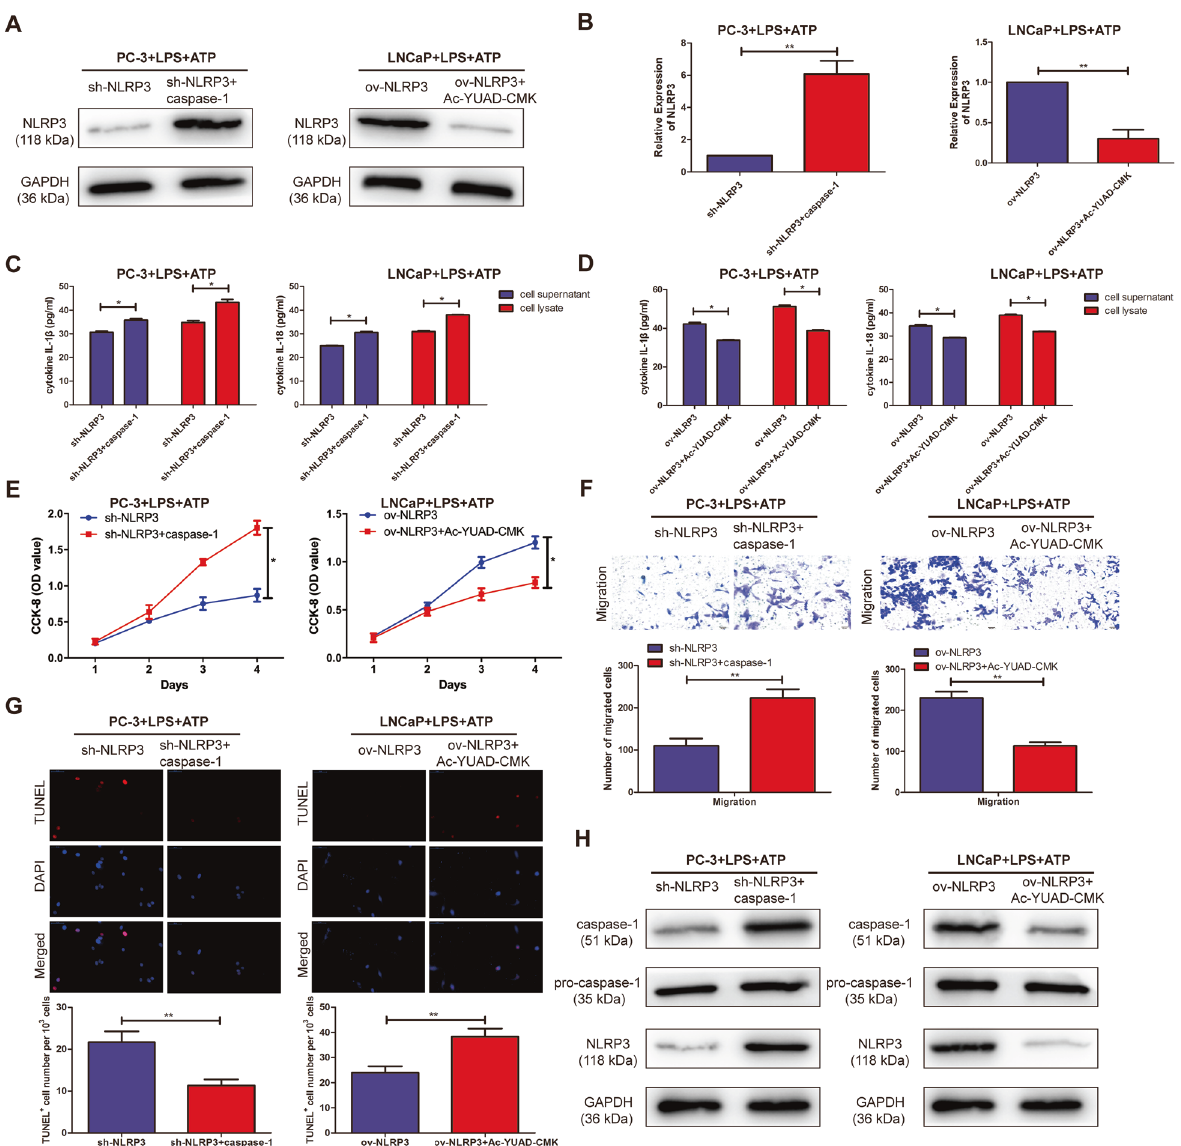
Fig. 4 NLRP3 in fl ammasome exerts oncogenic activity by activating caspase-1 in PCa cell lines. A Western blotting analysis veri fi ed the transfection ef fi ciency of NLRP3 after sh-NLRP3 + recombinant protein caspase-1 or ov-NLRP3 + Z-YVAD-FMK in PC3 and LNCaP cell lines, respectively. B qRT-PCR analysis veri fi ed the transfection ef fi ciency of NLRP3 after sh-NLRP3 + recombinant protein caspase-1 or ov-NLRP3 + Z-YVAD-FMK in PC3 and LNCaP cell lines, respectively. C The expression of IL-1 β and IL-18 in the supernatant and lysate of PC3 and LNCaP cell lines were signi fi cantly decreased in sh-NLRP3 + recombinant protein caspase-1, not in sh-NLRP3 alone. D The expression of IL-1 β and IL-18 in the supernatant and lysate of PC3 and LNCaP cell lines were signi fi cantly decreased in ov-NLRP3 + Z-YVAD-FMK, not in ov-NLRP3 alone. E CCK-8 assay detected the proliferation of PCa after sh-NLRP3 + recombinant protein caspase-1 or ov-NLRP3 + Z-YVAD-FMK in PC3 and LNCaP cell lines, respectively. F Transwell assay was used to detect the migration ability after sh-NLRP3 + recombinant protein caspase-1 or ov-NLRP3 + Z-YVAD-FMK in PC3 and LNCaP cell lines, respectively (magni fi cation: ×40). G TUNEL assay was used to detect the apoptosis after sh-NLRP3 + recombinant protein caspase-1 or ov-NLRP3 + Z-YVAD-FMK in PC3 and LNCaP cell lines, respectively (magni fi cation: ×40).